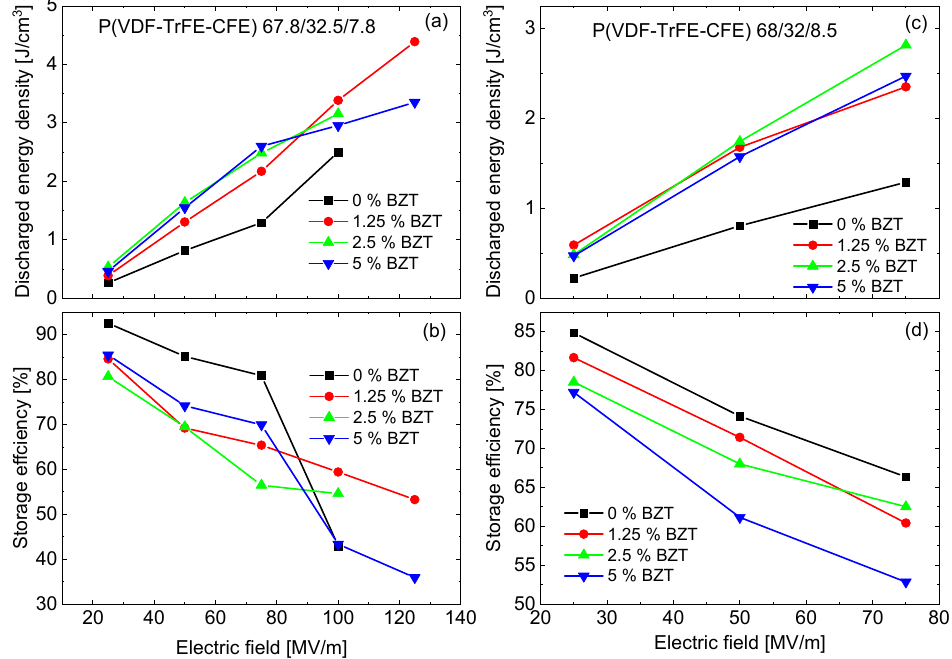
Figure 5. Discharge energy density ( a,c ) and storage efficiency ( b , d ) for the composite films based on P(VDF-TrFE-CFE) 64.8/35.2/7.8 ( a , b ), and 68/32/8.5 ( c , d ) terpolymers.